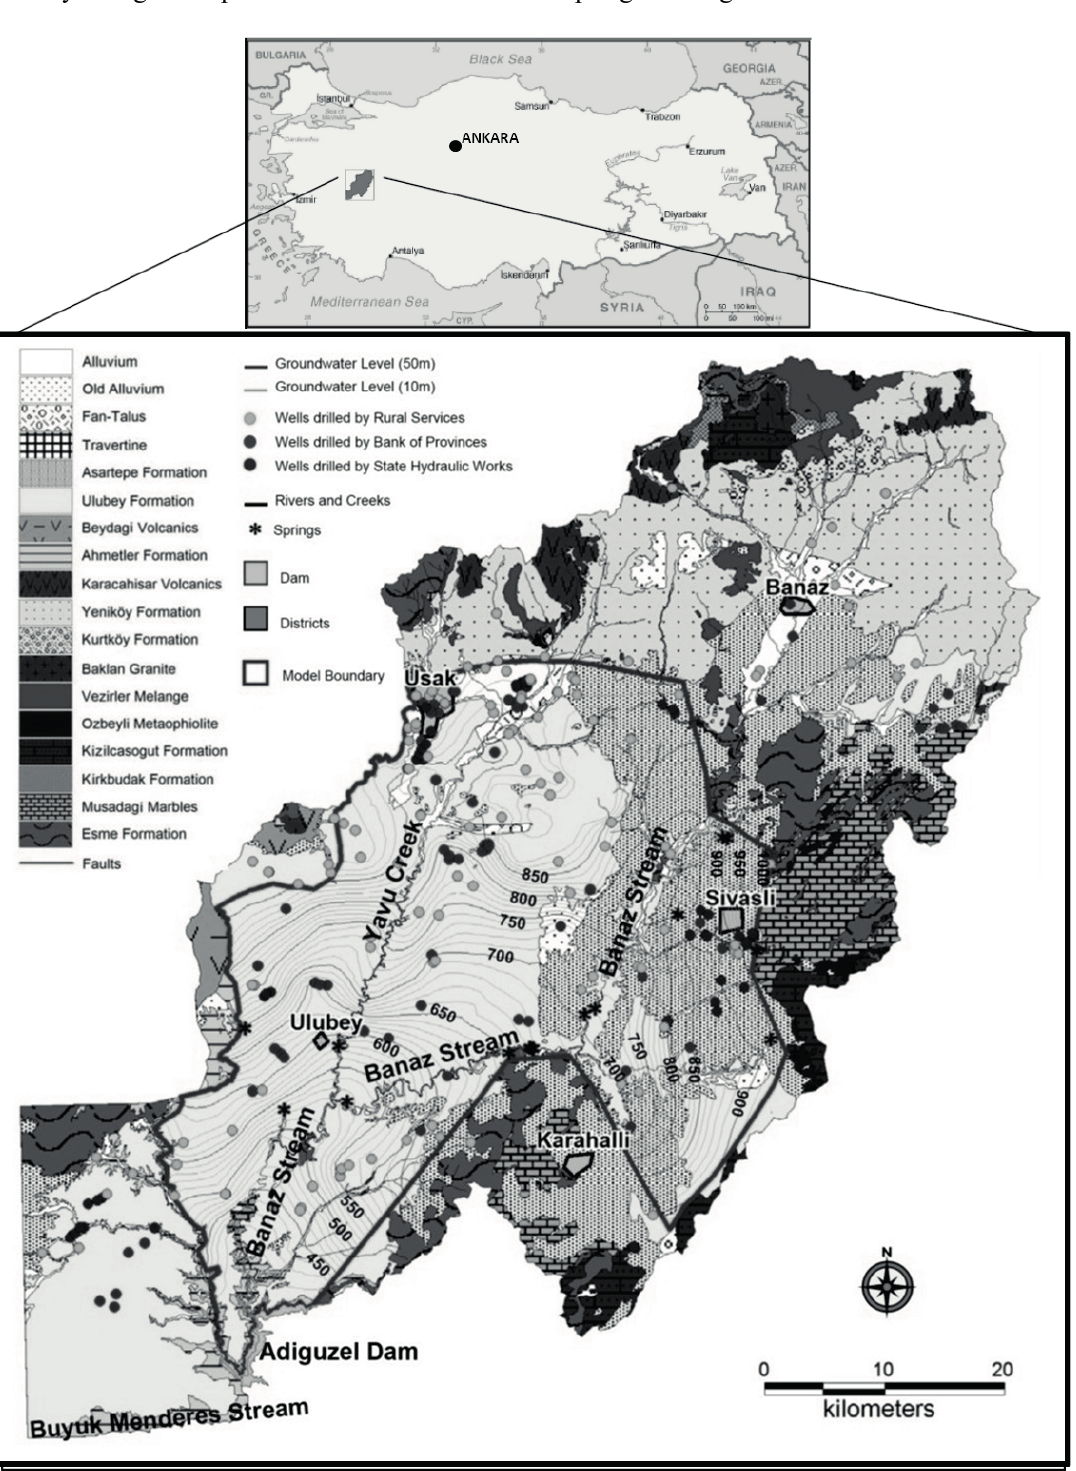
Fig.1 Location map of the study